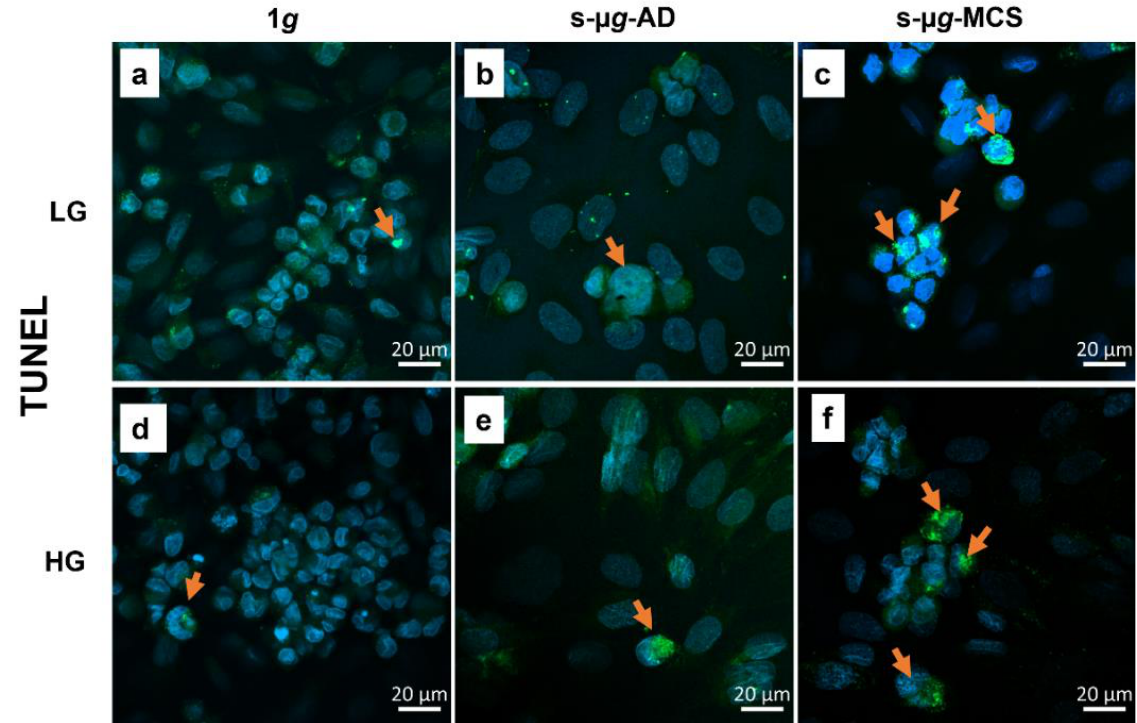
Figure 11. TUNEL assay after 14 days of cultivation, either at 1 g or on the clinostat and either using low (LG) or high (HG) glucose medium. ( a ) 1 g in LG; ( b ) s- µ g adherent cells in LG; ( c ) s- µ g multicellular structures in LG; ( d ) 1 g in HG; ( e ) s- µ g adherent cells in HG; ( f ) s- µ g multicellular structures in HG.